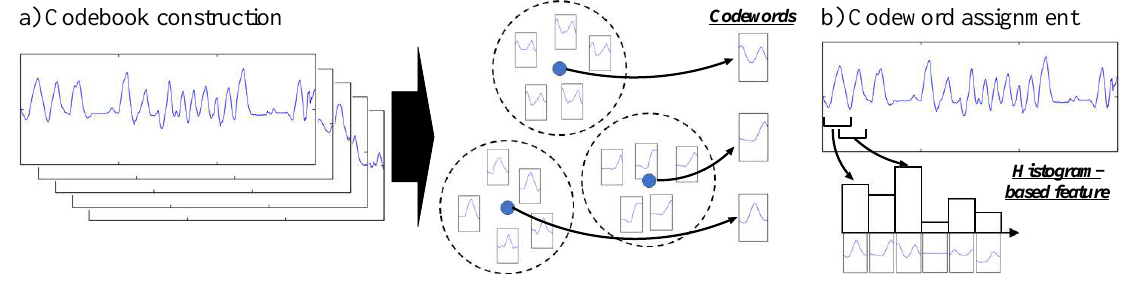
Figure 2. An overview of the codebook